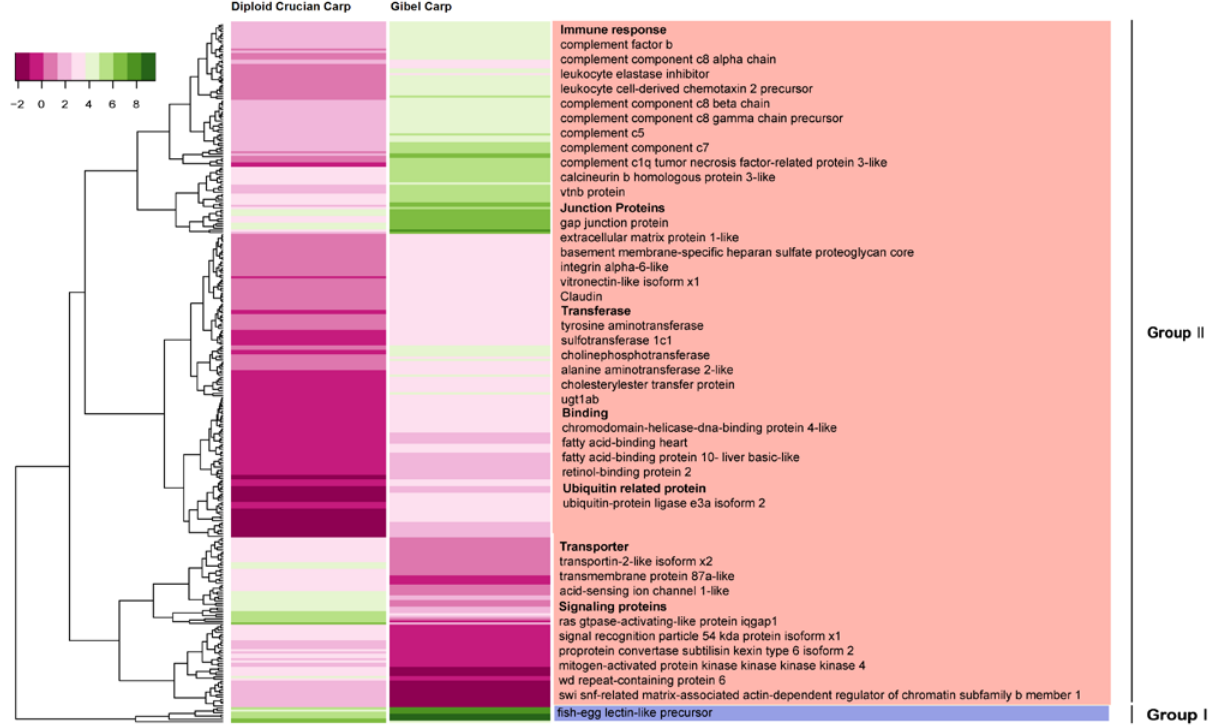
Figure 3. Expression profiling of differentially expressed orthologous genes in the two species. Hierarchical clustering shows that these genes can be classified into two groups (Group I and Group II). The group II could be further divided into two